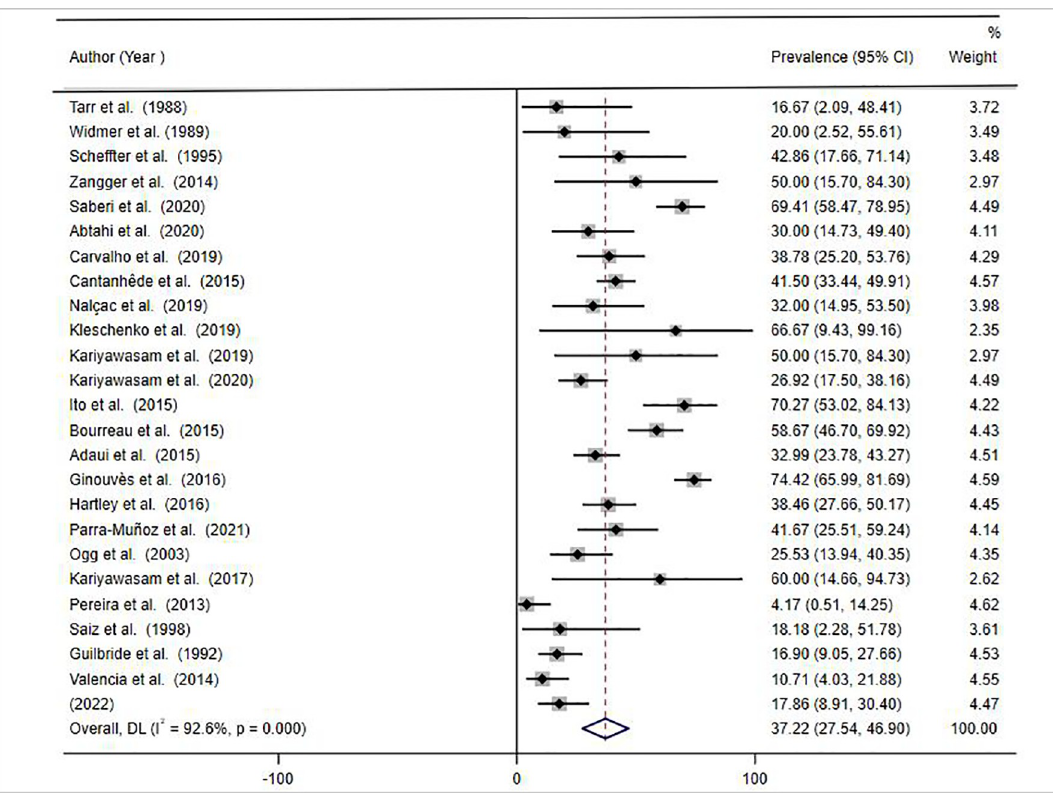
Fig 2. Forest plot diagram of included studies depicting the pooled and weighted prevalence of LRV in Leishmania isolates and/or lesions from CL patients, 2021.